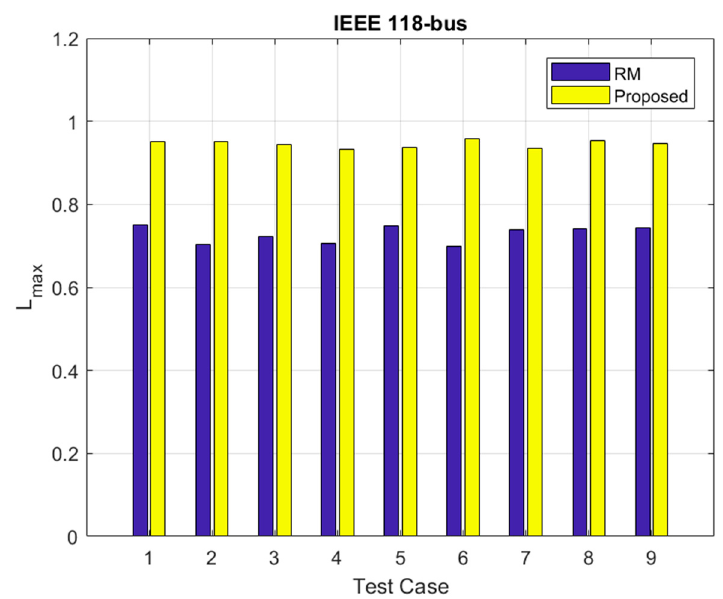
Figure 10. Comparisons for system load at voltage collapse point under different test cases in IEEE 118-bus model. A higher max L indicates a better performance.